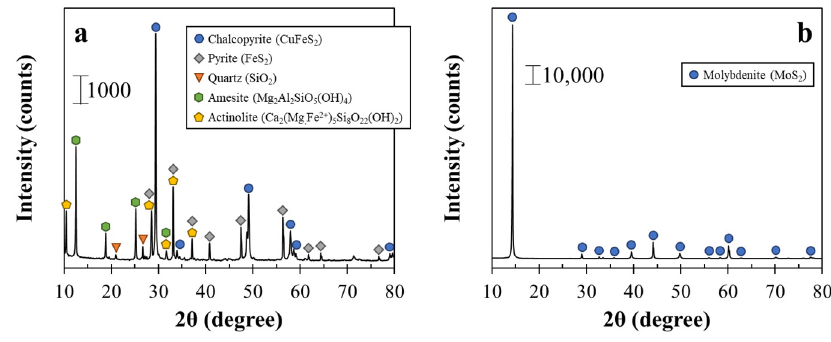
Figure 1. X-ray di ff raction (XRD) patterns of ( a ) chalcopyrite and ( b ) molybdenite. Figure 1. X-ray diffraction (XRD) patterns of ( a ) chalcopyrite and ( b ) molybdenite. Table 1. Elemental compositions of chalcopyrite and molybdenite. Table 1. Elemental compositions of chalcopyrite and molybdenite.